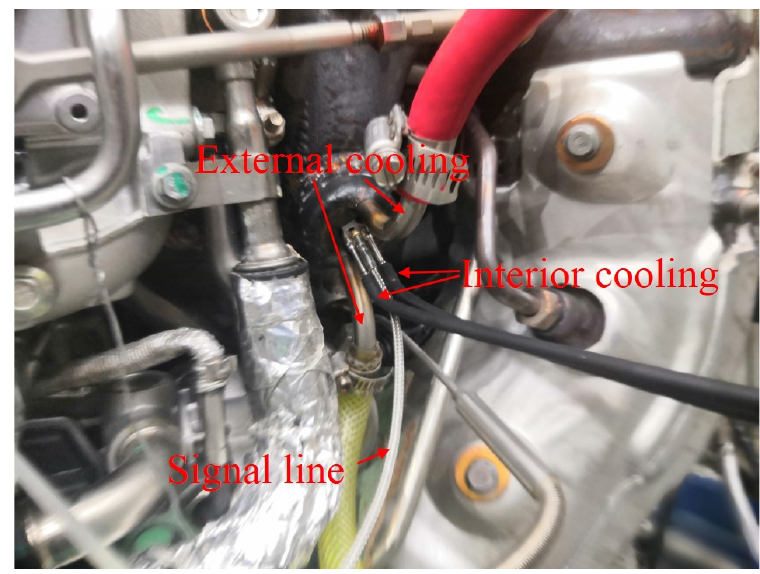
Figure 4. Exhaust pipe pressure transducer installation.